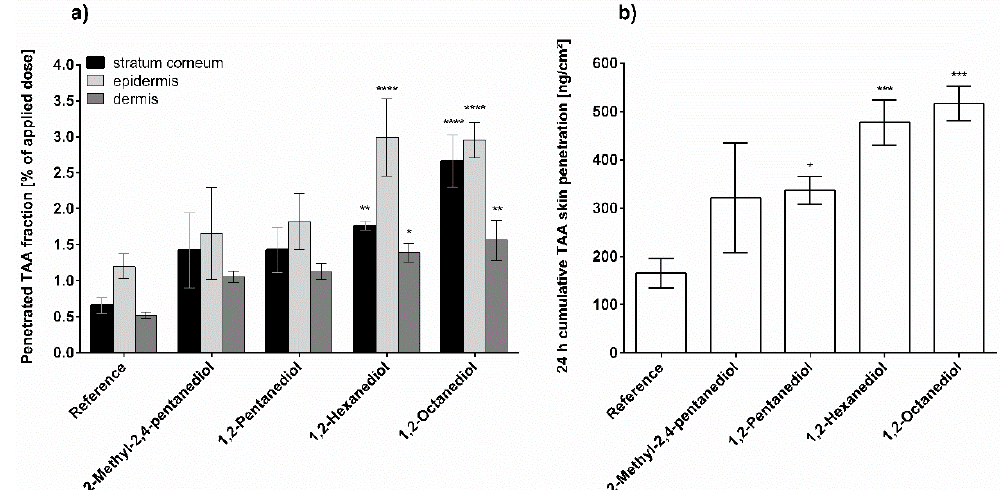
Figure 4. Triamcinolone acetonide penetration from pure nonionic hydrophilic cream (reference) and nonionic hydrophilic cream with 5% alkanediol after 24 h incubation; ( a ) Penetrated fraction in stratum corneum, viable epidermis and dermis; ( b ) Cumulative skin penetration of triamcinolone acetonide, n = 3, mean ± SD, * p ≤ 0.05; ** p ≤ 0.01; *** p ≤ 0.001; **** p ≤ 0.0001.